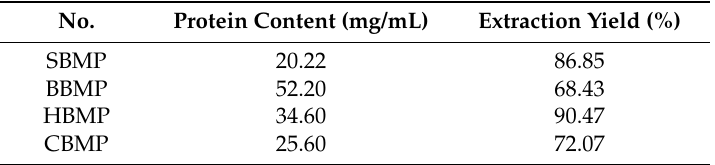
Table 1. Comparison of water extracted proteins from different bone